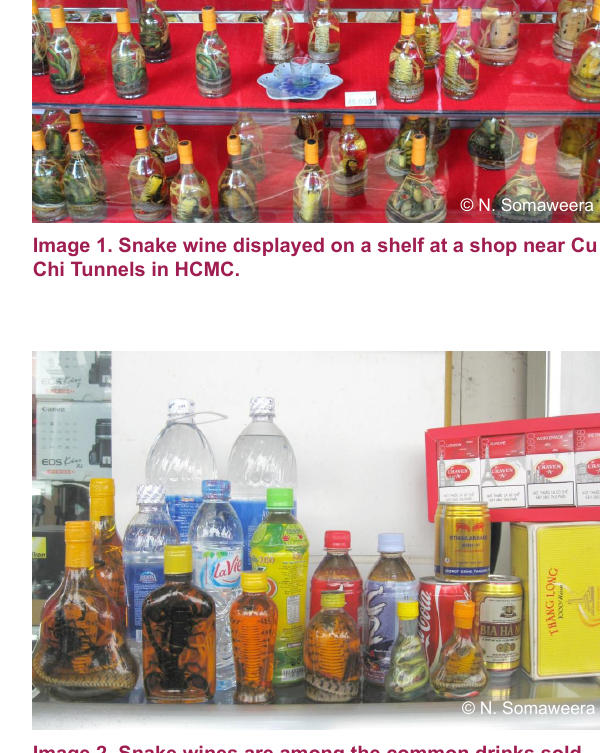
Image 2. Snake wines are among the common drinks sold on road sides in HCMC and Hanoi.